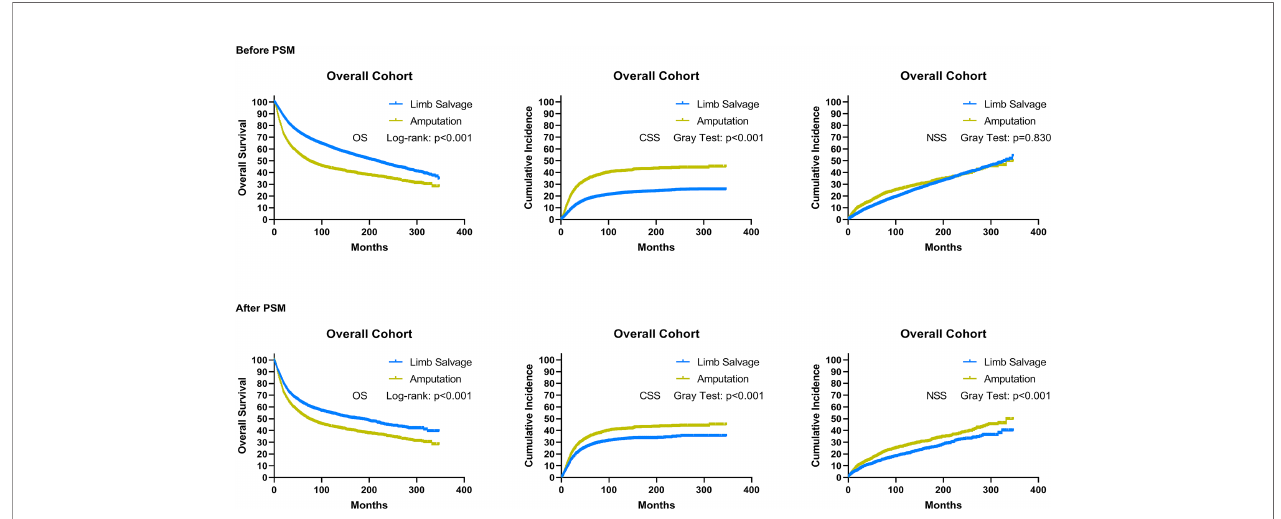
FIGURE 3 | As a whole, overall survival, cancer-speci fi c survival, and non-sarcoma survival for patients receiving limb salvage or amputation after EBST sarcomas using the initial cohort and cohort after PSM, respectively. PSM, propensity score-matched patients; OS, overall survival; CSS, cancer-speci fi c survival; NSS, non- sarcomas